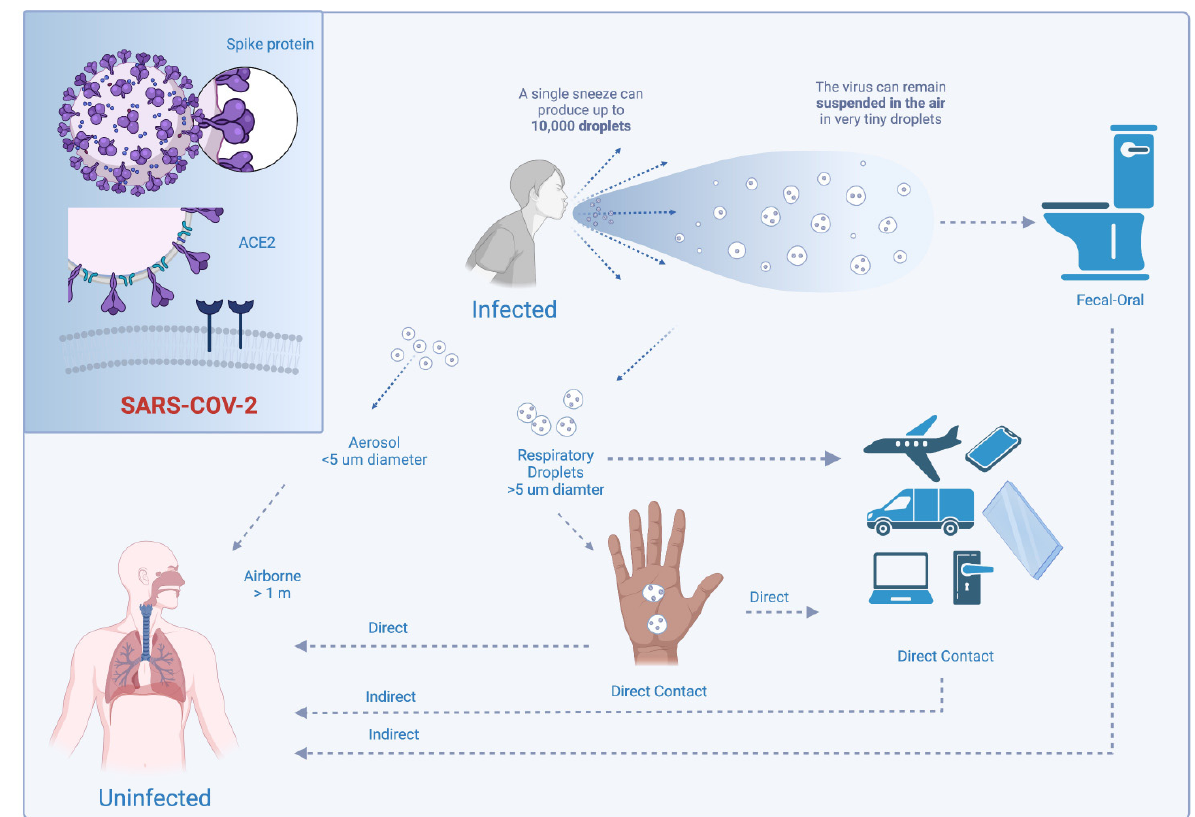
Figure 2. Modes of transmission of Sars-Cov-2. Modified from Harrison et al., 2020. Created with BioRender.com.